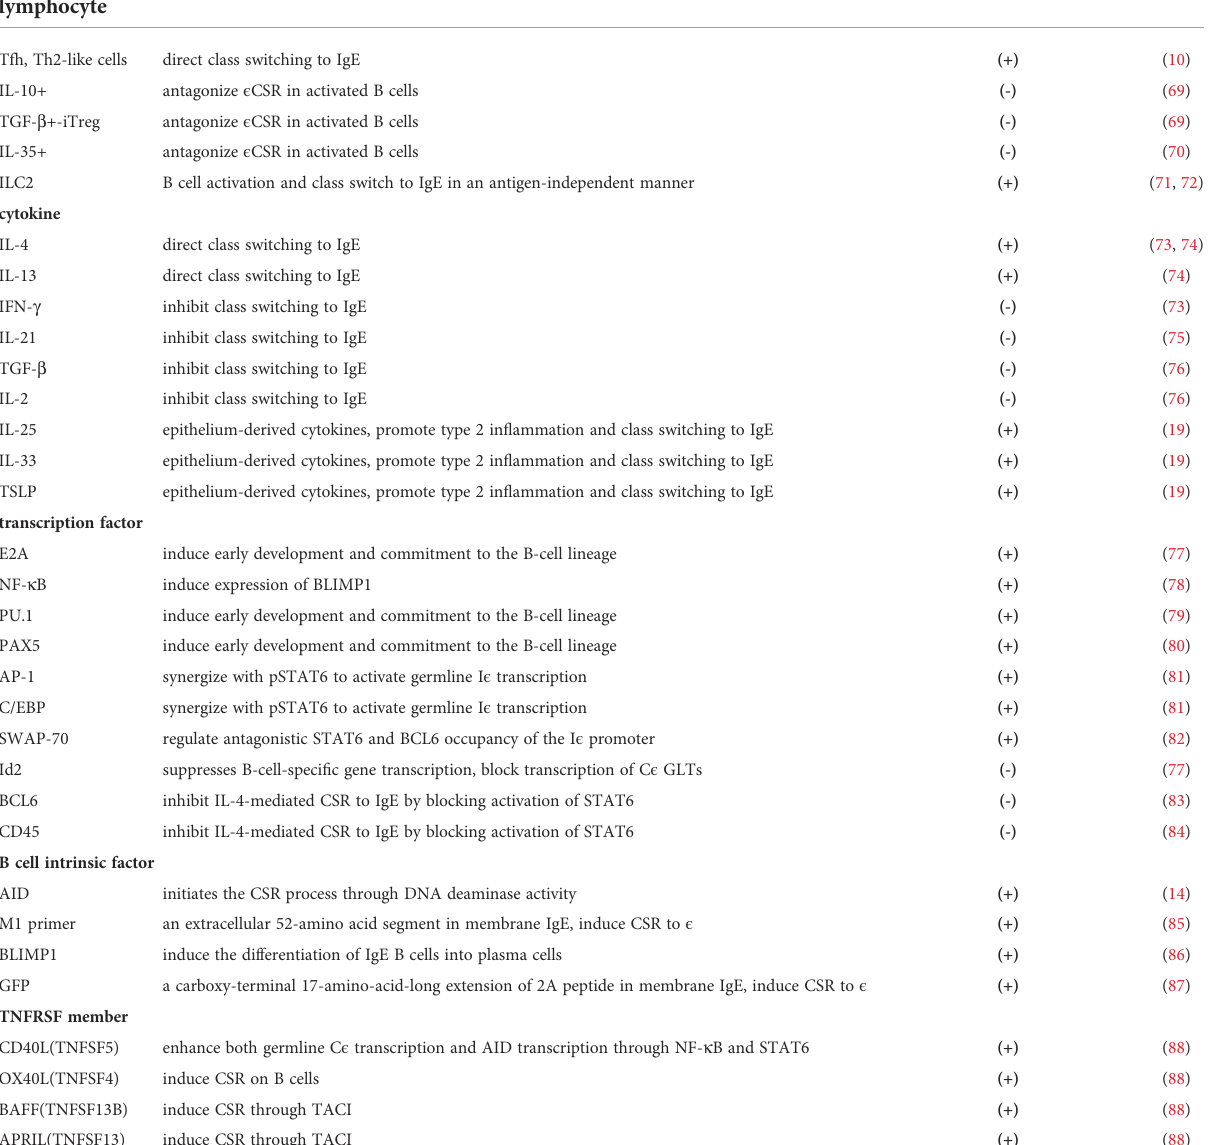
TABLE 2 Factors involved in the regulation of CSR to IgE